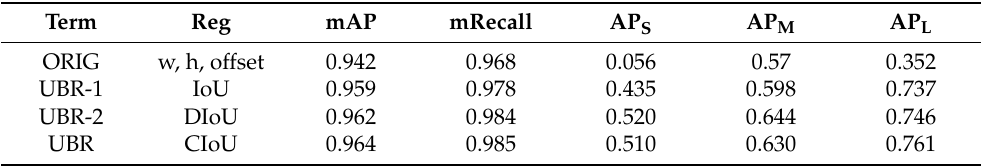
Table 2. Performance comparison among different settings of regression module. UBR, united bounding regression; AP, average precision.